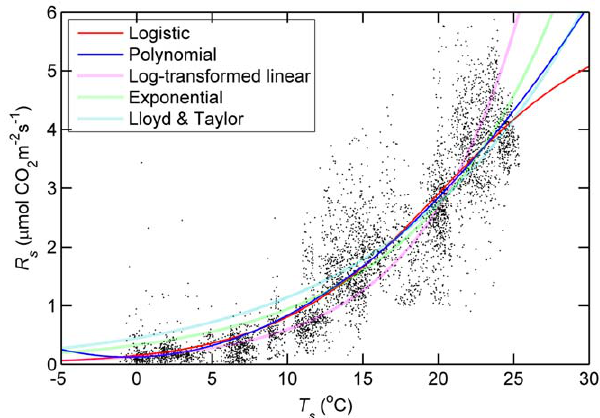
Figure 2. Hourly soil respiration ( R s ) as a function of soil temperature ( T s ) at 10 cm depth below ground. Data points were from May to December in 2008. Solid curves are fitted curves by equation listed in table